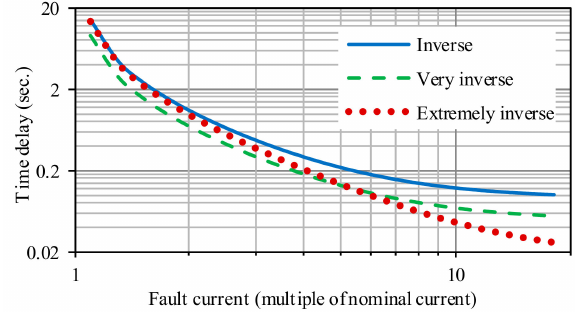
Figure 3. Time-current characteristic curves of typical over-current